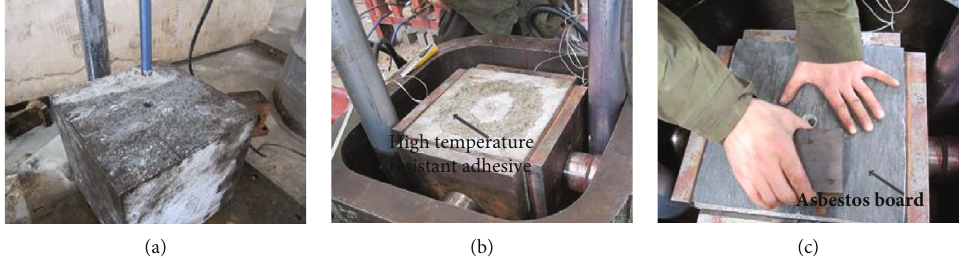
Figure 2: Granite sample: (a) drilling in the sample center; (b) application of the high-temperature-resistant adhesive to the samples; (c) fi x the asbestos board to the samples with the high-temperature-resistant adhesive. Table 1: The mineralogical compositions of Luhui granite.